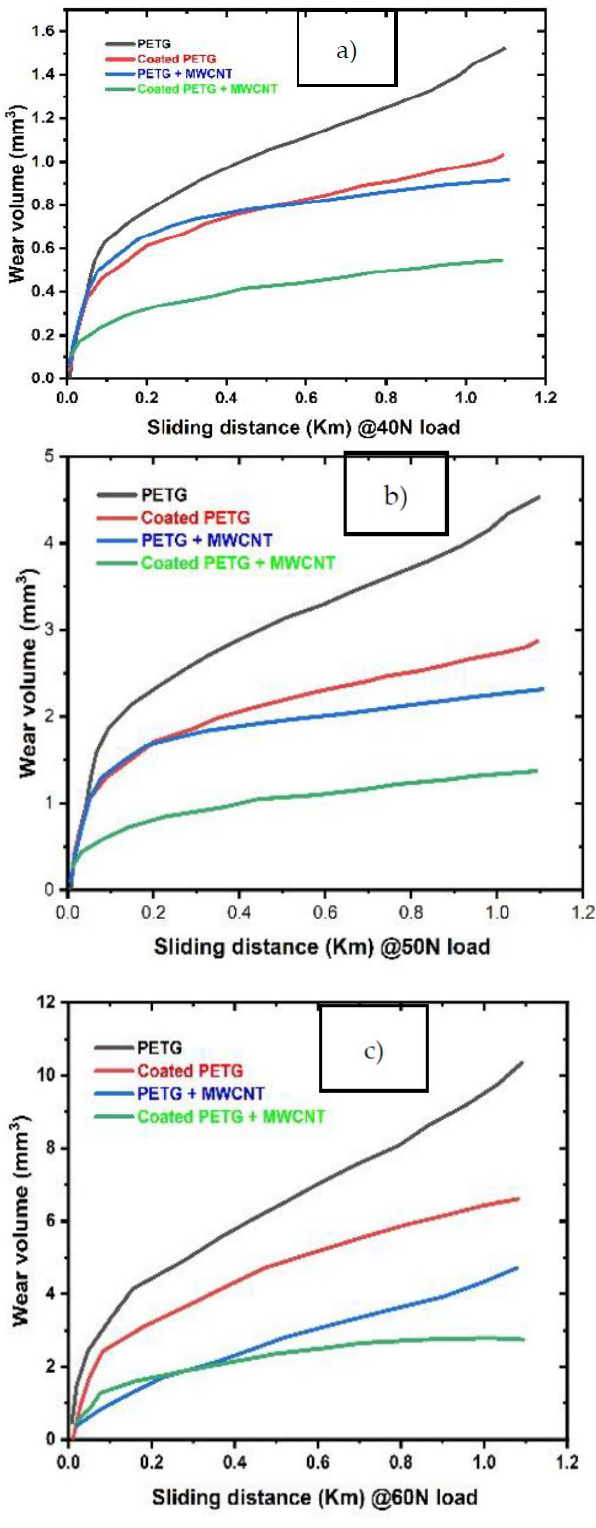
Figure 13. Wear volume for the sliding distance at: ( a ) 40 N load; ( b ) 50 N load; ( c ) 60 N load.